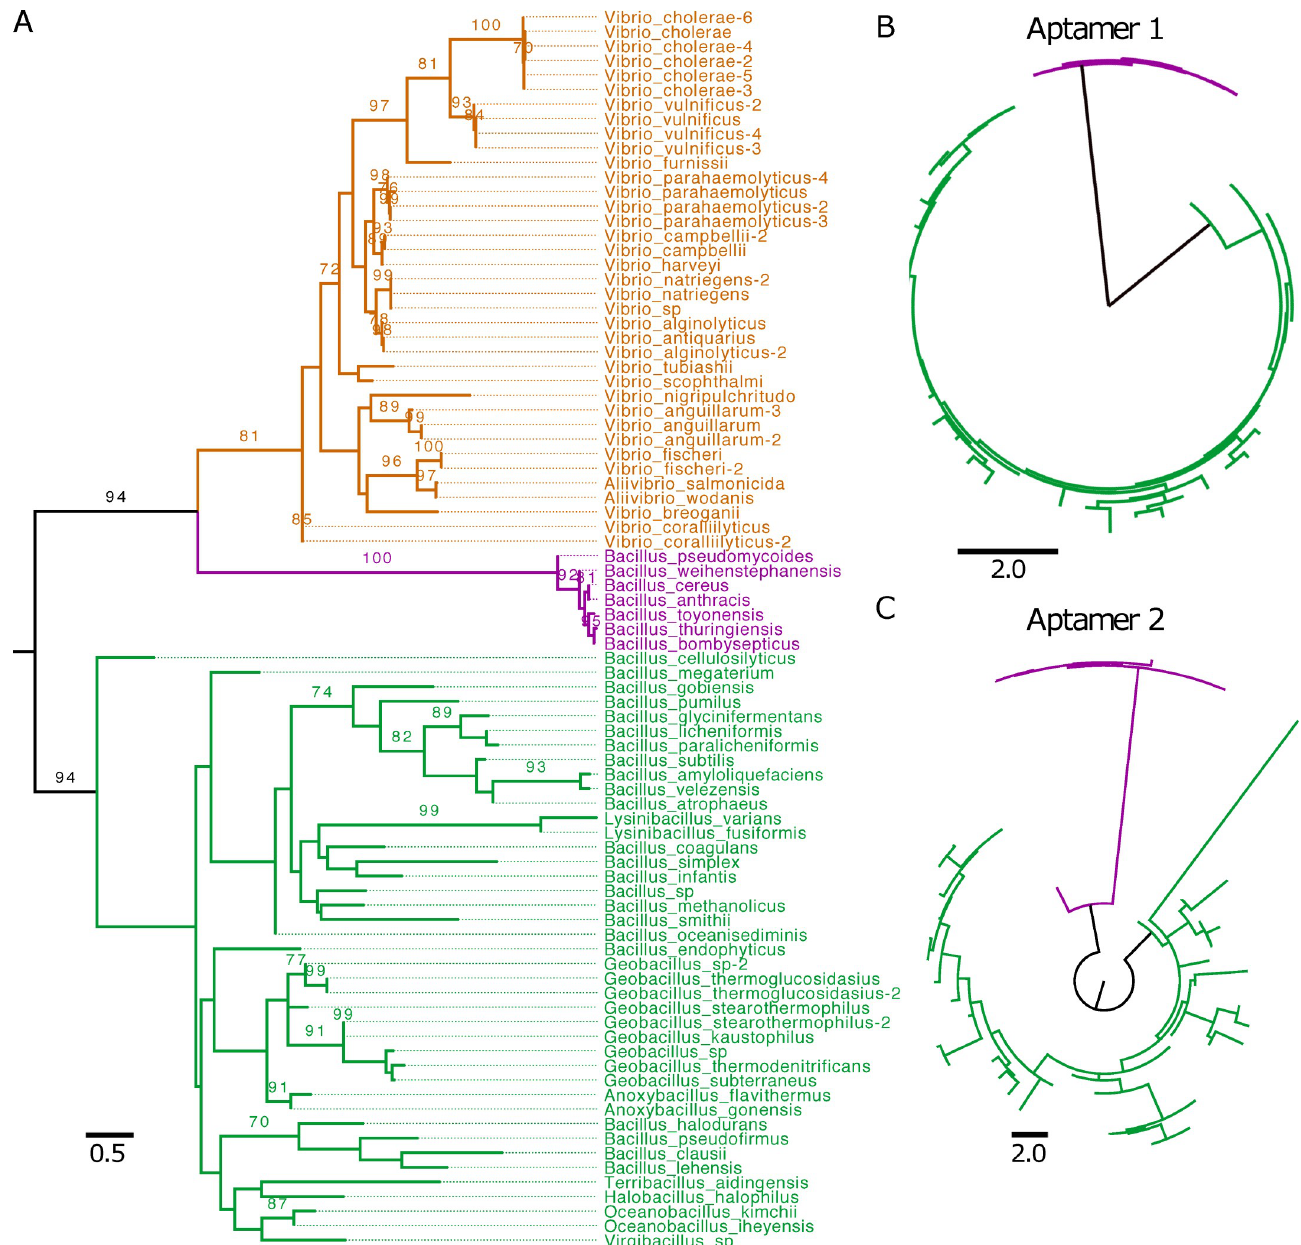
Fig 1. Phylogenetic comparison of tandem riboswitches across Bacillaceae and Vibrionaceae. A) 48 Bacillaceae and 37 Vibrionaceae tandem riboswitches were clustered based on aptamer sequence and structure across both aptamers of the riboswitch. After phylogenetic clustering, individual aptamers were colored based on the class of gene being regulated and the bacterial family of origin ( Vibrionaceae TP are orange, Bacillaceae TP are purple, Bacillaceae GCV are green). Clusters have been labeled with the bacterial family and gene class being regulated. Bootstrap support values are displayed for 100 replicates when > = 70. B,C) Phylogenetic clustering of 48 tandem riboswitches, separated into aptamer-1 (B) and aptamer-2 (C), taken from the Bacillaceae family and colored according to class of gene being regulated (GCV are green, TP are purple). All trees are midpoint